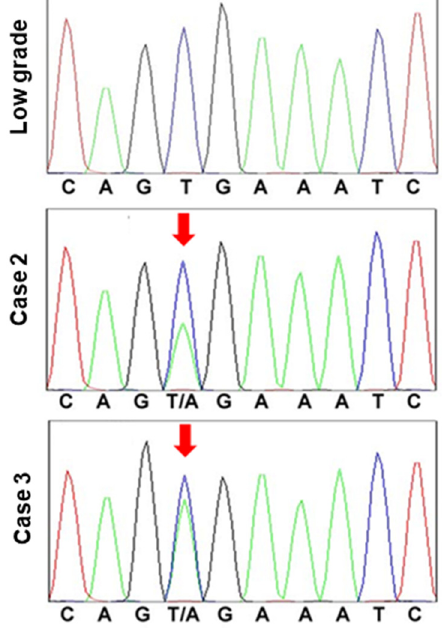
Figure 4. BRAF mutation in hyperplastic polyp carcinoma.